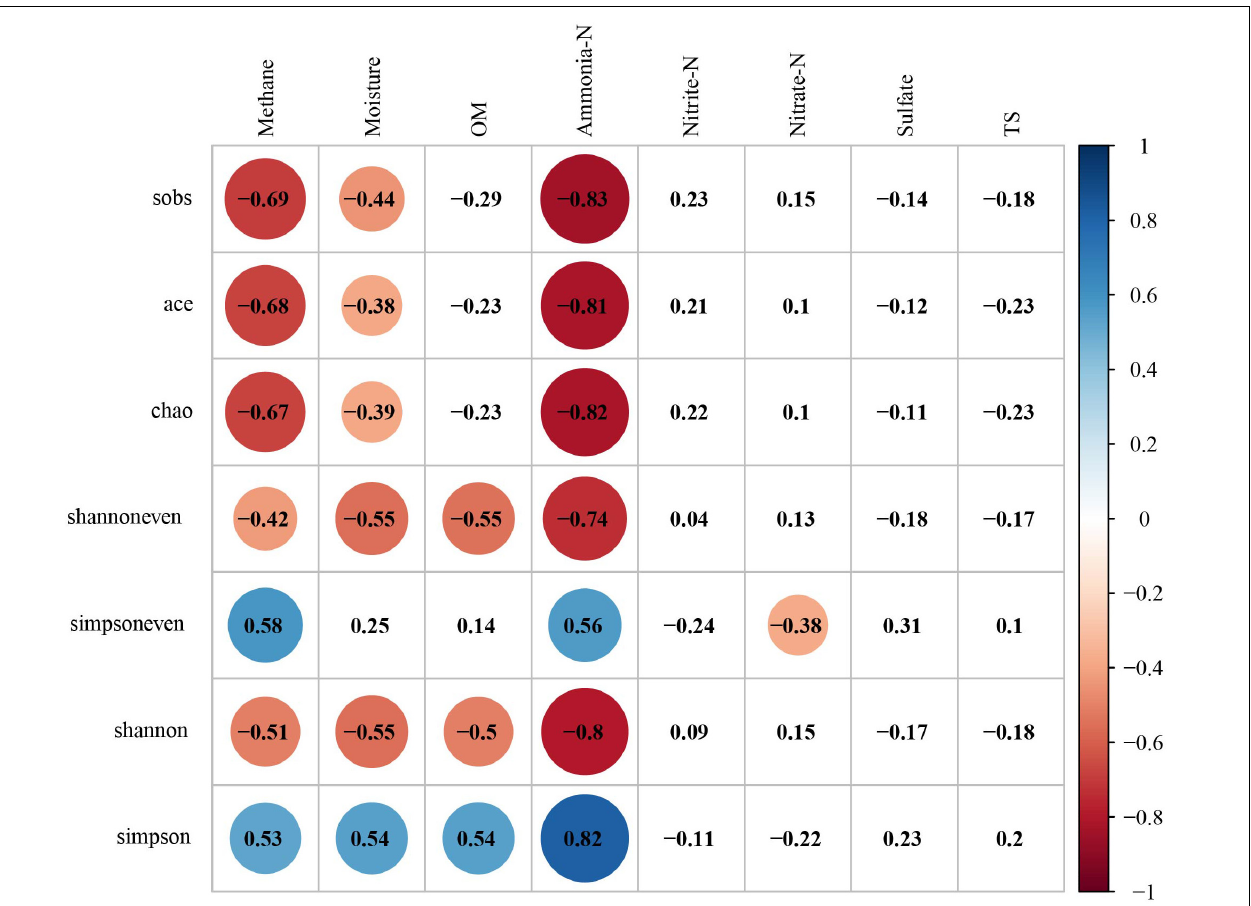
FIGURE 6 | The correlation analysis between the species diversity of archaeal community, methane and environmental factors (Digits represents Pearson correlation coefficients; filled color indicates significant correlation, blue represents positive correlation, red represents negative correlation, shade of color represents strength of